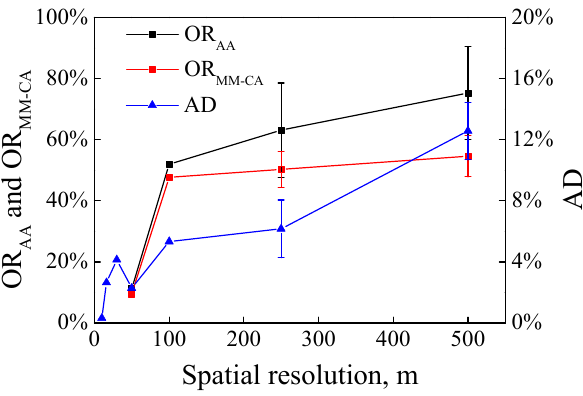
Figure 4. OR AA , OR MM-CA and AD of macroalgae vary with spatial resolution. As shown by Figure 3a3,b3,c3, the macroalgae-covered zones are empirically divided into some subzones and the MM-CA, the AA, the AD and the OR are calculated for each subzone. Significant decreasing trends in OR with the increase of AD are observed for all the three group images (Figure 5). The above results suggest that the omission of small patches in the satellite detections are more likely to occur when the aggregation density (AD) is low.